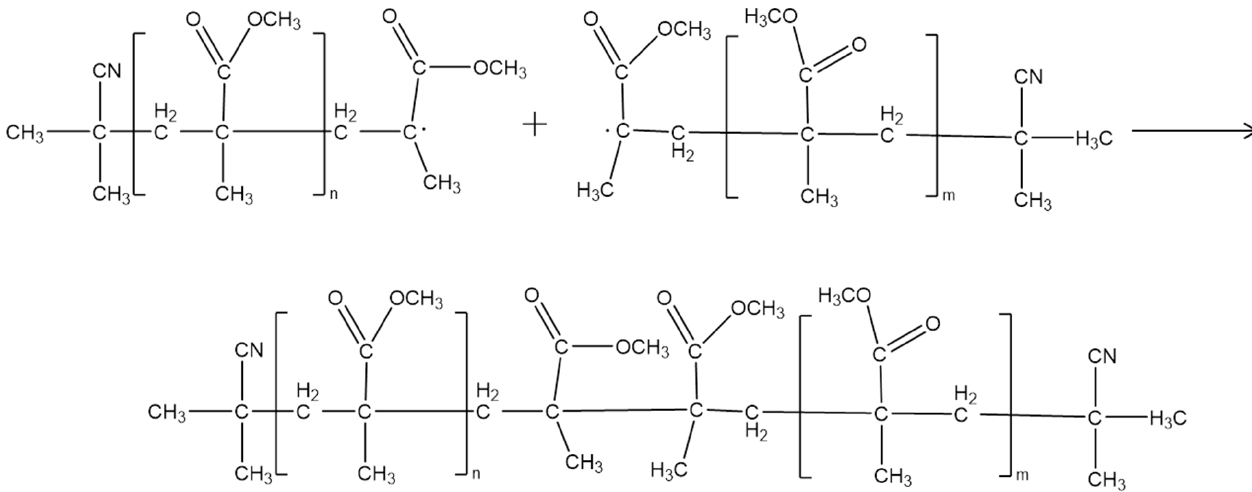
Figure 10. Coupling termination products.